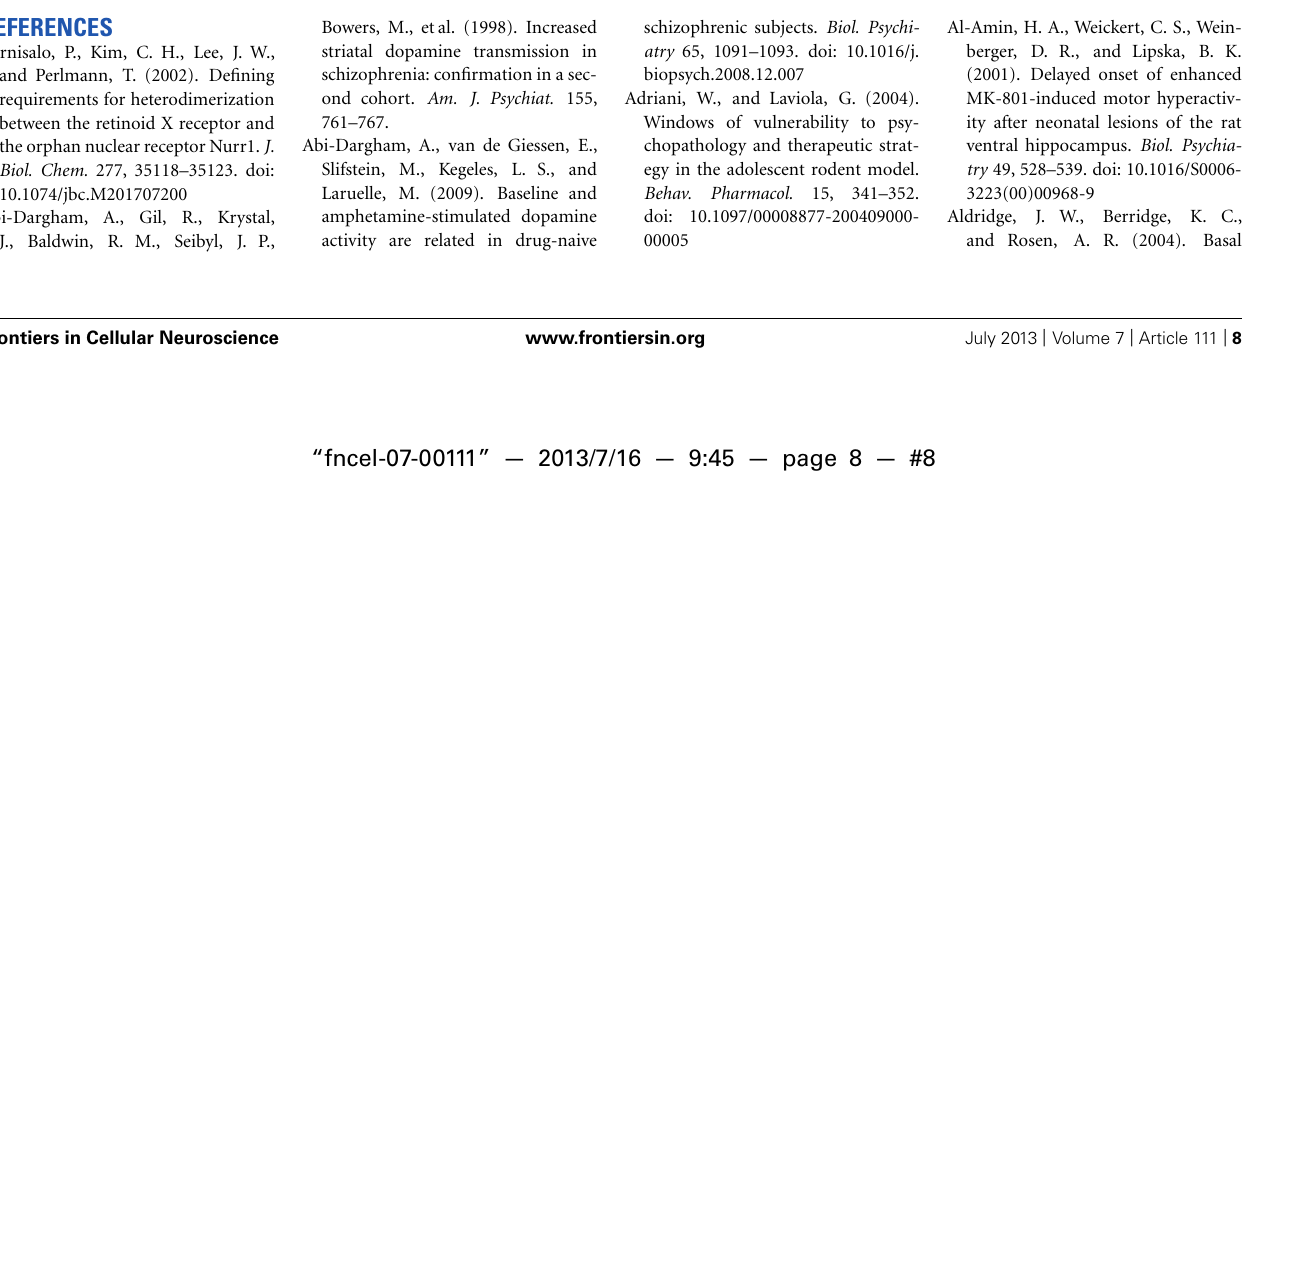
treatment on persisting negative symptoms suggest they are not directly related to dopamine function. Rather, they represent the downstream consequence of early dopamine dysfunction or the extraneous effects of specific genetic and environmental risk factors on other neurotransmitter systems such as glutamate and GABA. These non-specific actions, outside of the core schizophrenia etiology, result in a large heterogeneous profile of negative symptoms in